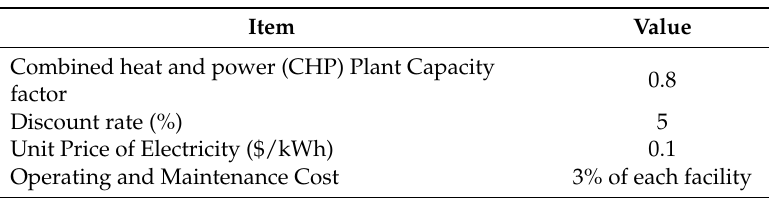
Table 8. Parameters for economic analysis.